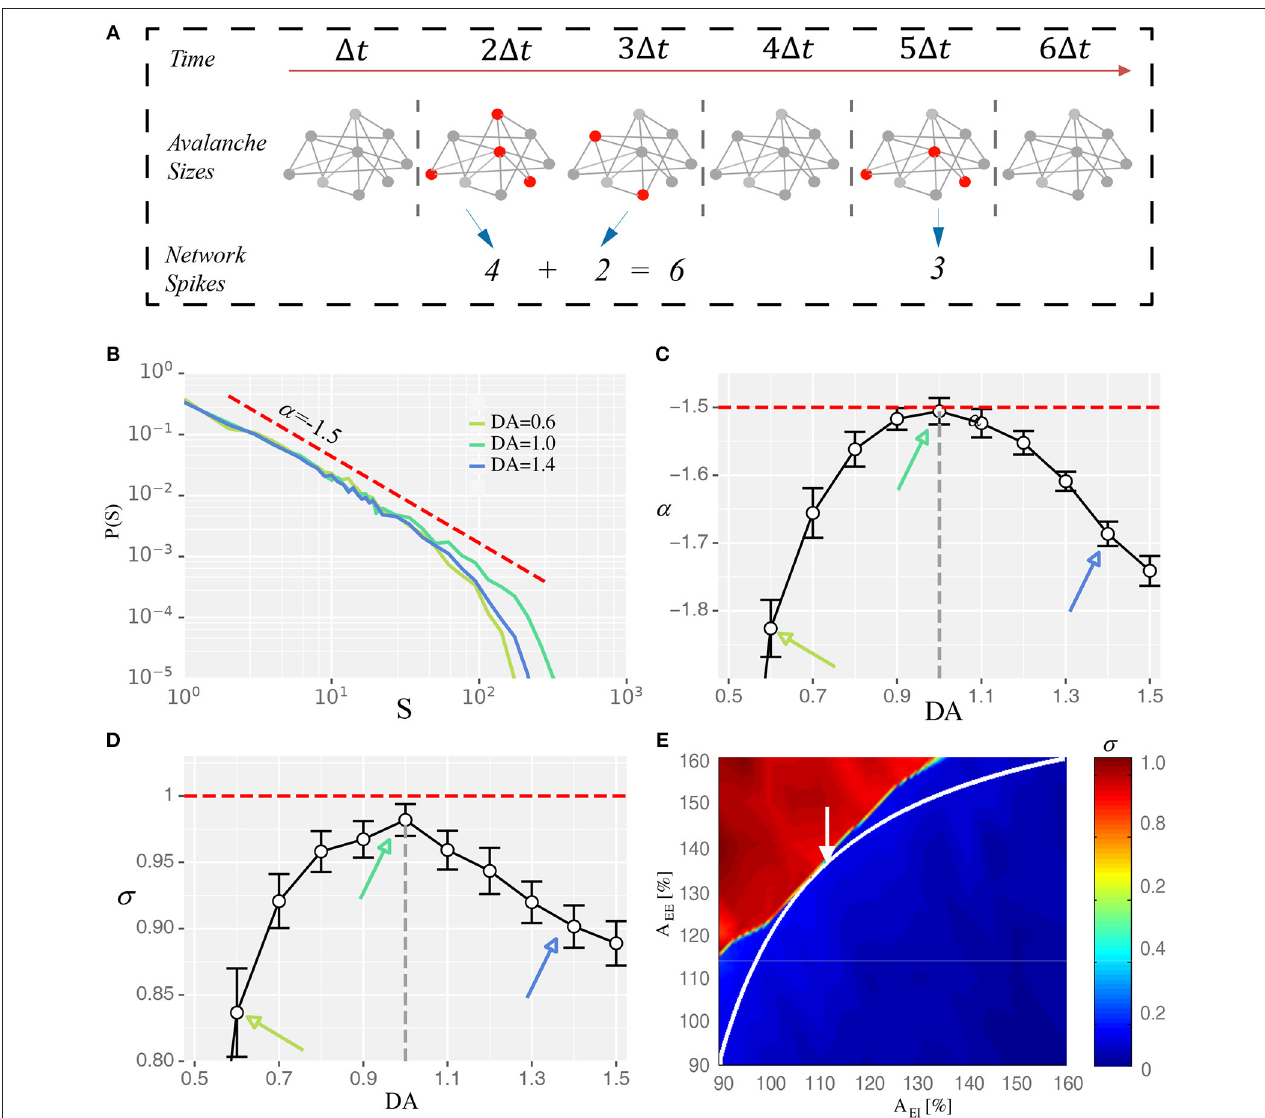
FIGURE 3 | Intermediate D1 activation corresponds to a state close to criticality. (A) Schematic diagram showing the identification of neuronal avalanches. Solid circles represent individual neurons, with red donating active state and gray donating quiescence. Neurons that fire in the same time bin or consecutive bins of length 1 t form an activity cascade, i.e., an avalanche. Avalanche size, s , is defined as the number of active neurons in the cascade. Two avalanches ( s 6 and 3) are shown. = (B) Avalanche size distribution obtained with three different levels of D1 activation, with the intermediate level (DA 1.0) associated with distribution closest to a = power-law exponent of 1.5 (red dashed line). (C,D) The exponent ( α ) and the branching parameter ( σ ) change as a function of the D1 activation level. Red dotted − lines represent α 1.5 and σ 1 in (C,D) , respectively. States corresponding to DA 0.6, 1.0, and 1.4 are marked by arrows with the same color as in (B) . α and = − = = σ estimated with different D1 activation levels are statistically significant (one-way ANOVA, p < 0.05; post-hoc test among DA 0.6, 1.0, and 1.4, p < 0.05; Data are = represented as